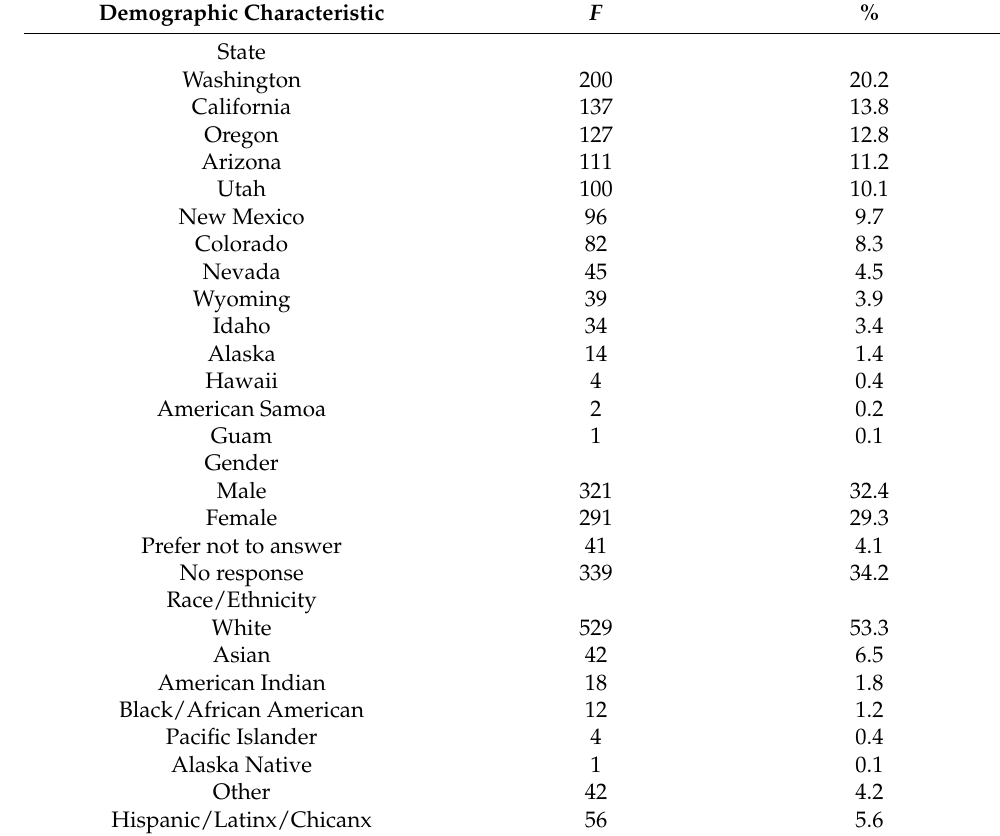
Table 1. Demographic characteristics of the respondents (N =